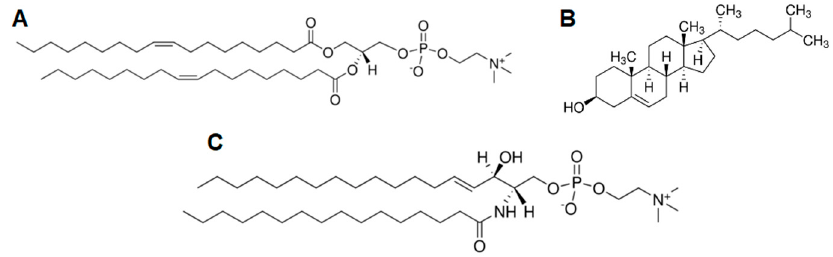
Figure 1. Chemical structures of lipids: ( A ) 1,2-dioleoyl-sn-glycero-3-phosphocholine (DOPC); ( B ) Cholesterol (Chol); ( C ) Sphingomyelin (SM).